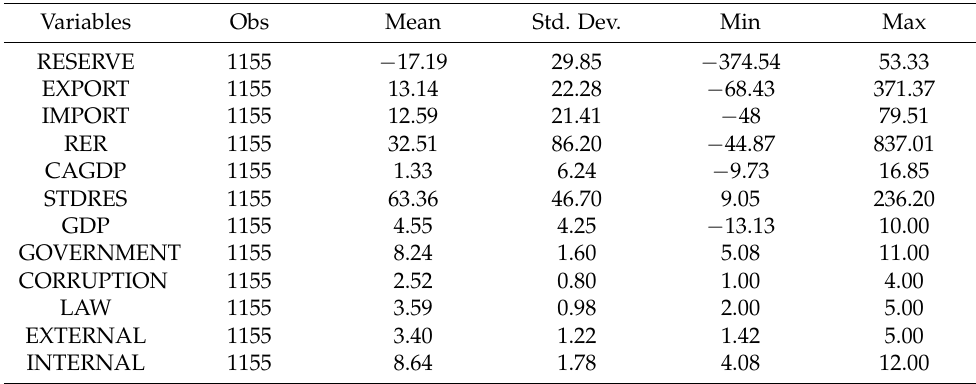
Table 1. Summary of descriptive statistics. Table Panel A: Summary of descriptive statistics of the entire period, 1992–2011